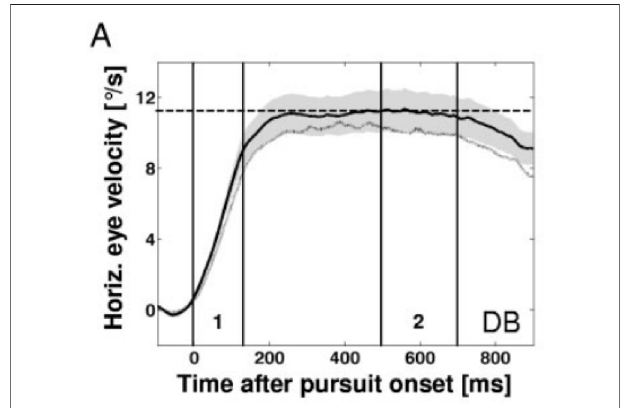
FIGURE 3 | Eye velocity (plotted line) and visual target velocity (dotted line) over time (x-axis), aligned to pursuit onset (0 ms). Smooth pursuit acceleration seen from 0 to 140 ms. Smooth pursuit latency seen from origin to 0 ms (Spering and Gegenfurtner,